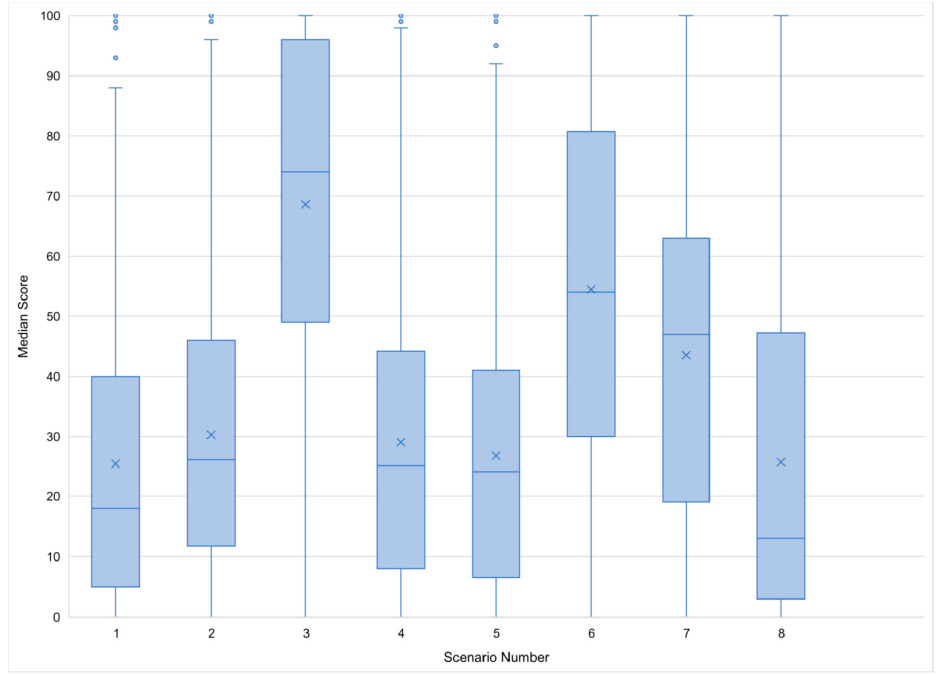
Figure 3. Box and whisker plot of scenario (eight numbered scenarios) scores as assigned by survey respondents (n = 901). Vignettes were scored between 0 (poor welfare) and 100 (good welfare) on a sliding scale.